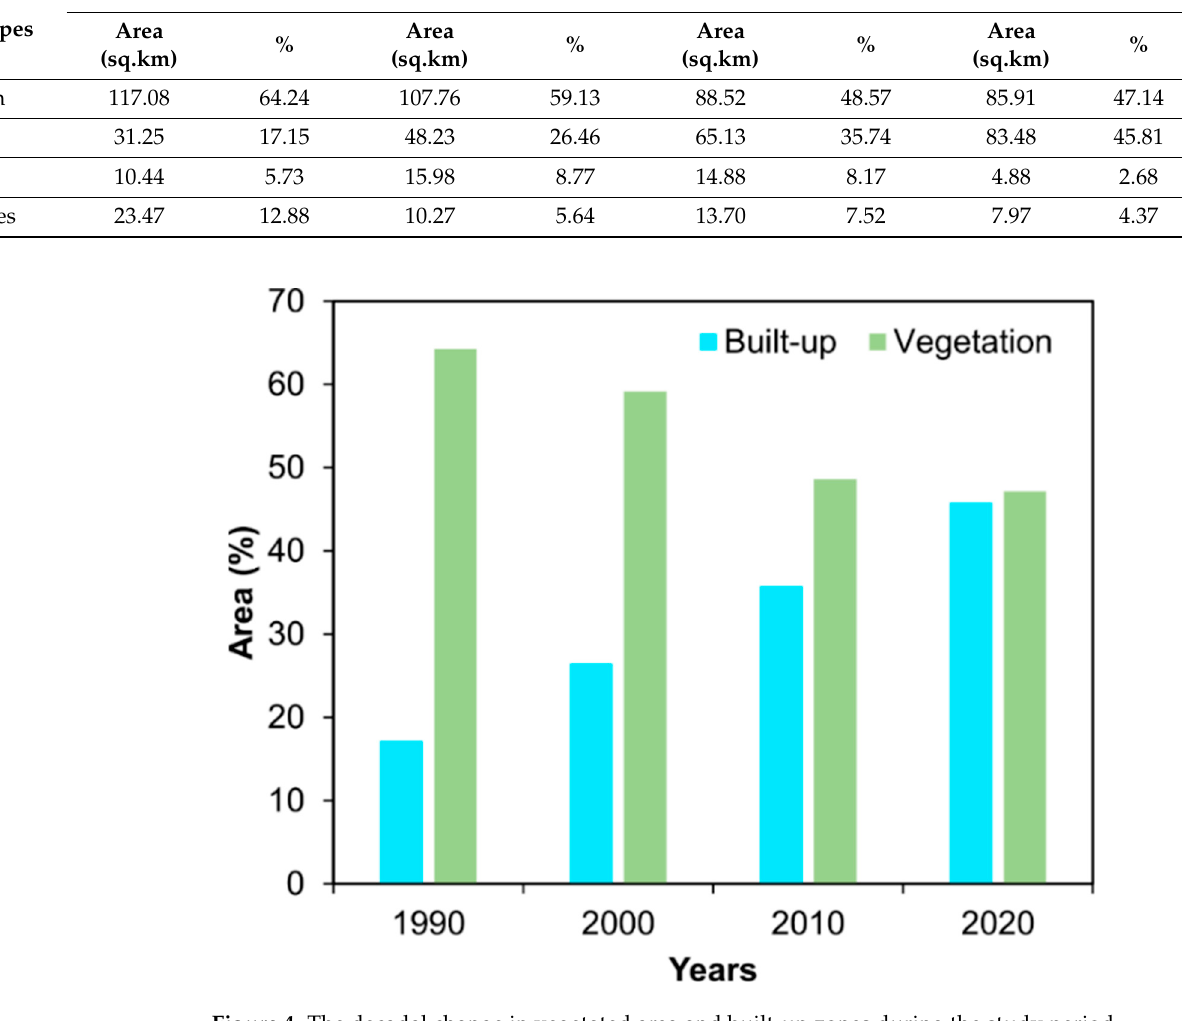
Figure 4. The decadal change in vegetated area and built-up zones during the study period.